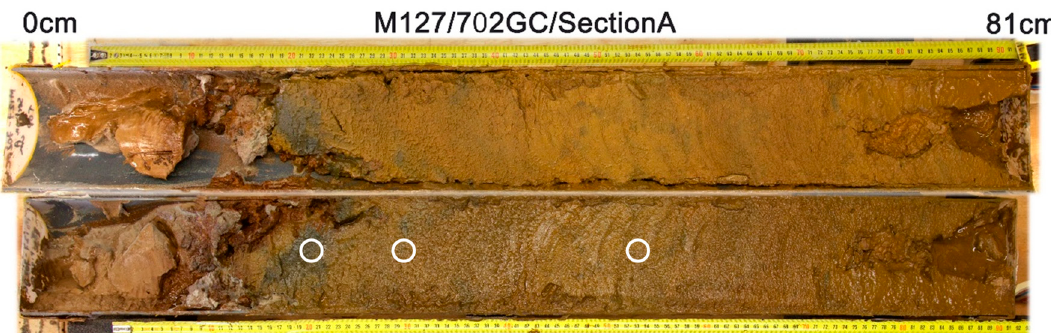
Figure 7. Image of the sediment core GC-702 with sampling points (white circles).